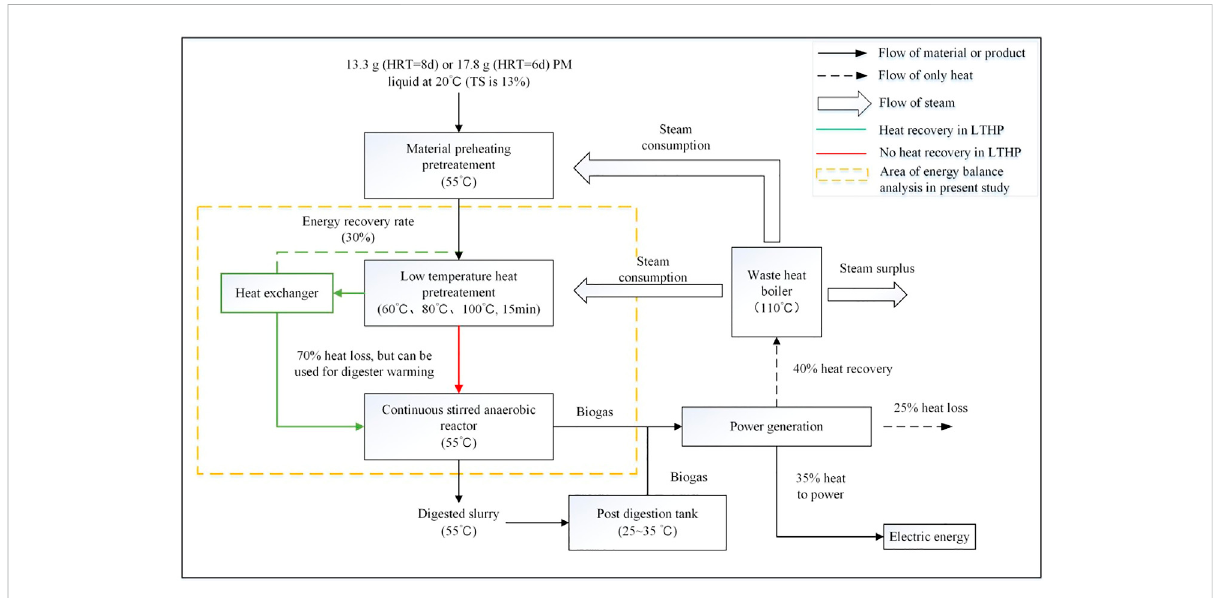
FIGURE 1 Flows of materials, products and energy of HSAD containing